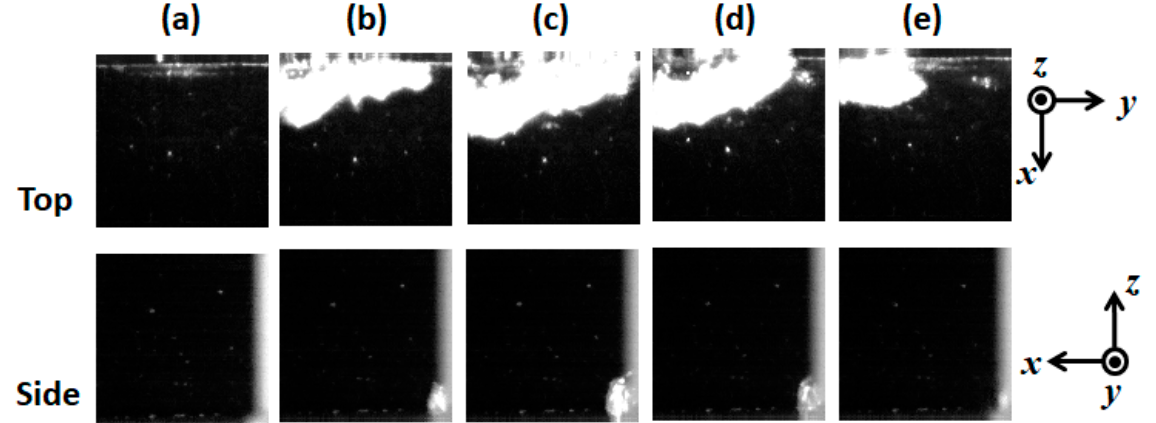
Figure 8. Instantaneous visualization using the synchronized signal with two high-speed cameras at a heat flux of 1.9 MW/m 2 : ( a ) 77.8 ms, ( b ) 78.1 ms, ( c ) 78.4 ms, ( d ) 78.7 ms, and ( e ) 78.9 ms.